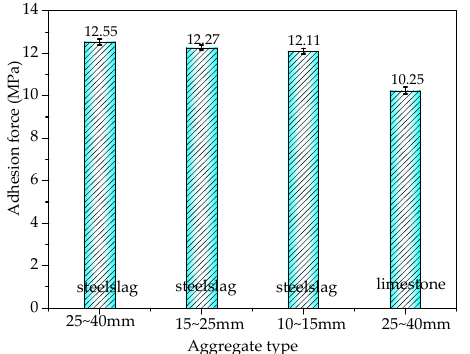
Figure 2. Effect of the particle diameter of steel slag on the adhesion at the asphalt–steel slag interface.